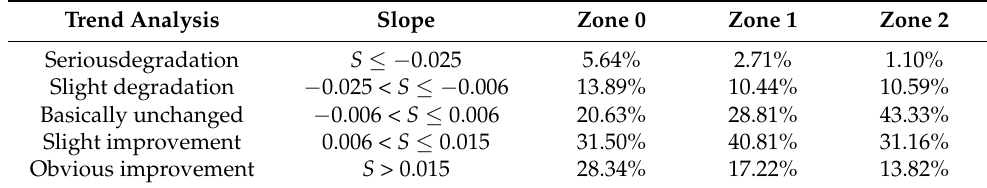
Table 5. Trend of NDVI from 2013 to